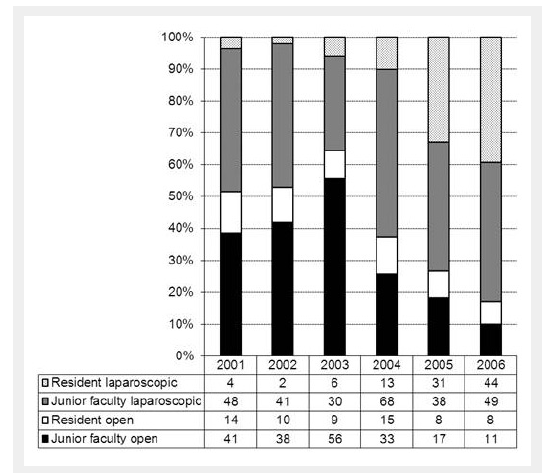
Percentage and absolute numbers of procedures by status of the surgeon (residents / junior faculty members).